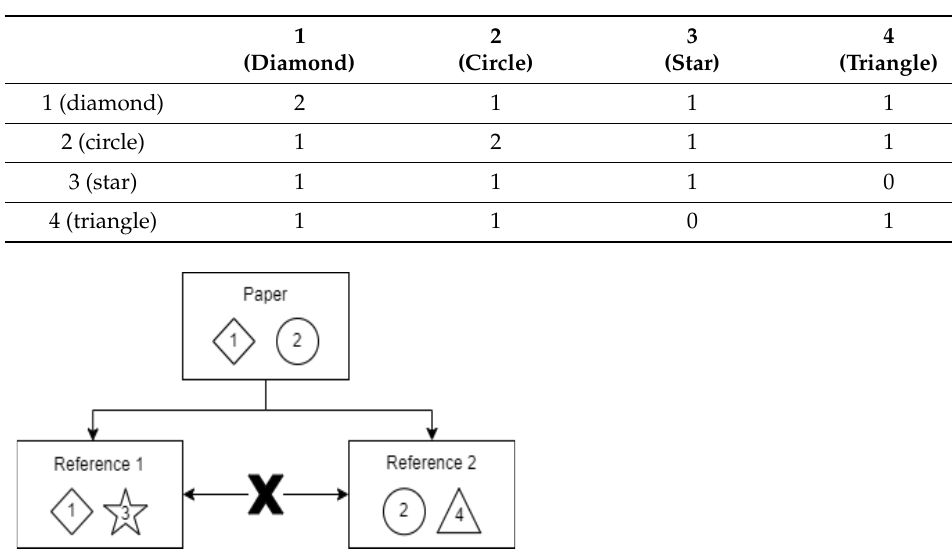
Figure 1. Primary – secondary relation between paper and its references. In conventional co-citation based on paper research disciplines the Cartesian relation between all research disciplines of a paper would be accounted for (upper dashed rectangle). Likewise, in conventional co-citation based on references the Cartesian relation between all referenced research disciplines would be considered (lower dashed rectangle). In this work, solely the Cartesian product between paper research disciplines and referenced research disciplines is considered. Table 1. Corresponding frequency matrix for Figure 2.